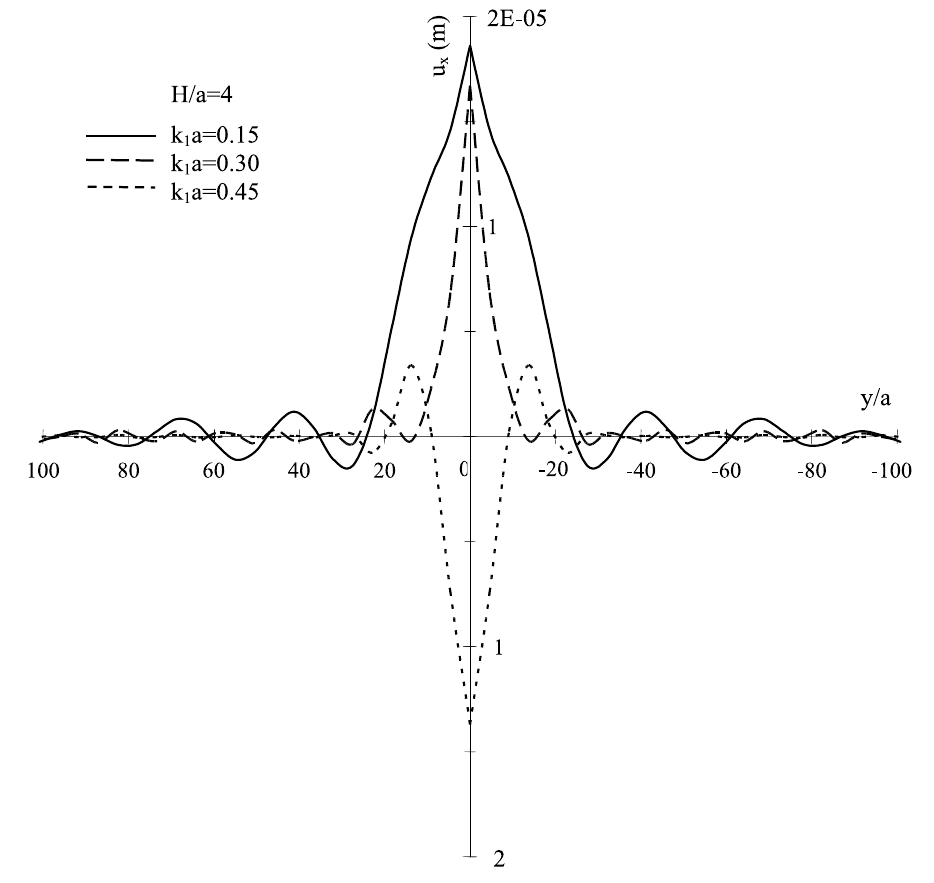
Fig. 5. Variation of the vertical displacement ( u x ) with y/a at the free surface of the half-space for various values of wave number k 1 a . increases for all values of k 1 a . Maximum displacements occurred at y / a = 0, x = H / a , i.e., at the point nearest the top of the cavity, and their values decrease as k 1 a increases. It should be noted that the horizontal displacements (not shown here) are zero at this point due to symmetry about the vertical ( x ) axis, and that the horizontal displacement values are small compared with the vertical displacements at other points of the free